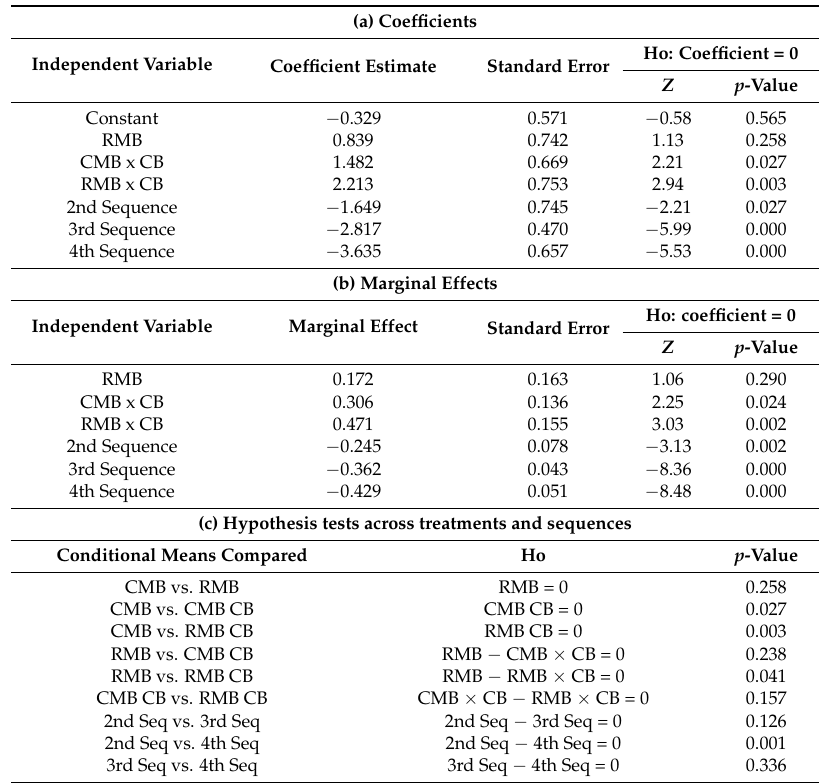
Table 4. Logit Model with Robust Clustered Standard Errors. Dependent Variable: 1 if Group Project Completed, 0